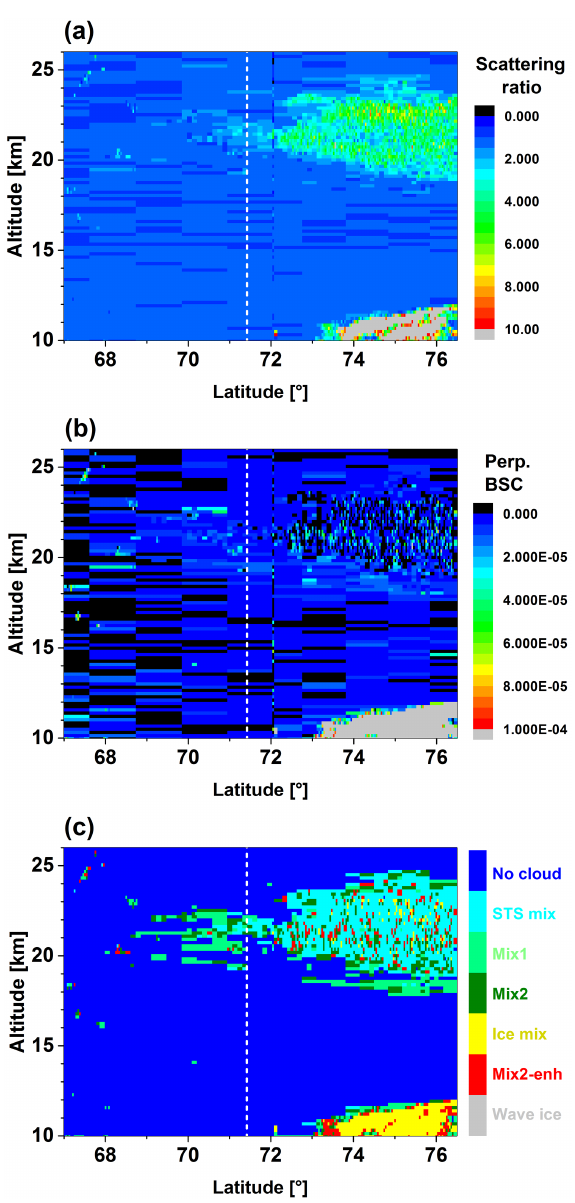
Figure 3. CALIPSO PSC observations associated with the Geo- physica flight on 11 December 2011. (a) Scattering ratio at 532nm. (b) Perpendicular backscatter (BSC) at 532nm. (c) PSC classifi- cation according to Pitts et al. (2011, 2013). White dashed lines: latitude of northernmost observations aboard the Geophysica .